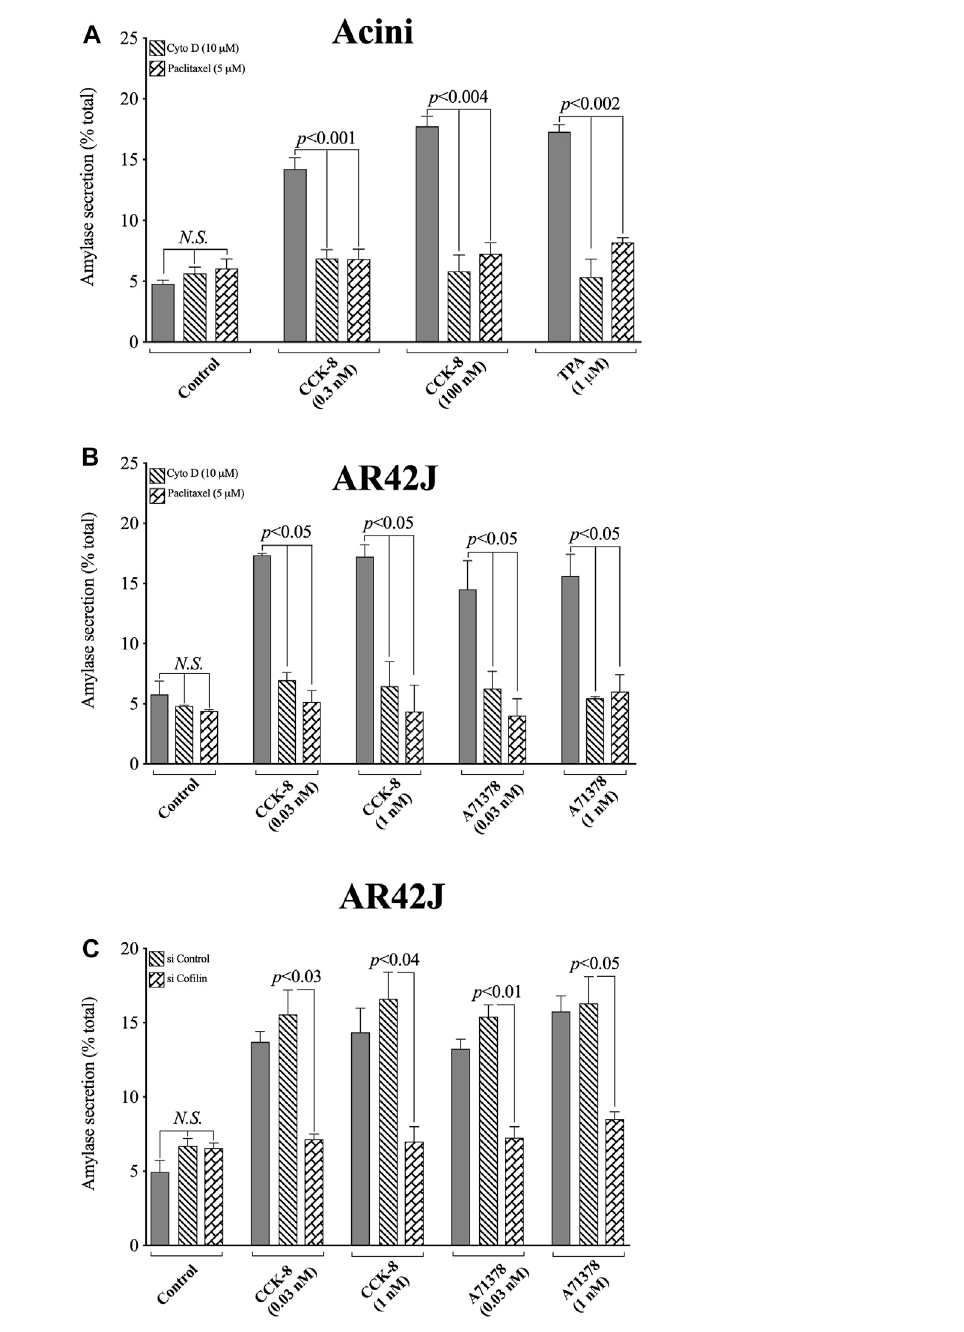
FIGURE 13 Effectoftwoco fi lininhibitors,CytochalasinDorPaclitaxel, (A,B) ,orCo fi linsiRNA (C) ,ontheabilityofCCK/TPA/A71378-stimulatedamylaserelease form pancreatic acini (A) or AR42J cells (B, C). In (A, B) pancreatic acini and AR42J cells were incubated in the absence or presence of Cytochalasin D (10 µM) or Paclitaxel (5 µM) for 4 h and then incubated with no additions (control) or CCK-8 (0.03, 0.3, 1 and 100 nM), TPA (1 µM) or A71378 (0.03 and 1 nM) for 30 min and then lysed. In (B, C) AR42J cells were treated with Dexamethasone (100 nM) for 72 h, and in (C) AR42J cells were transfected with siRNA Non-targeting Control and siRNA against co fi lin for 48 h, and then incubated with no addition (control) or CCK-8 (0.03 and 1 nM) and A71378 (0.03 and 1 nM) for 30 min. Amylase release, expressed as percent of cellular total amylase secreted, was determined after 30 min incubation. Means ± S.E. of at least 3 independent experiments. N.S. , No signi fi